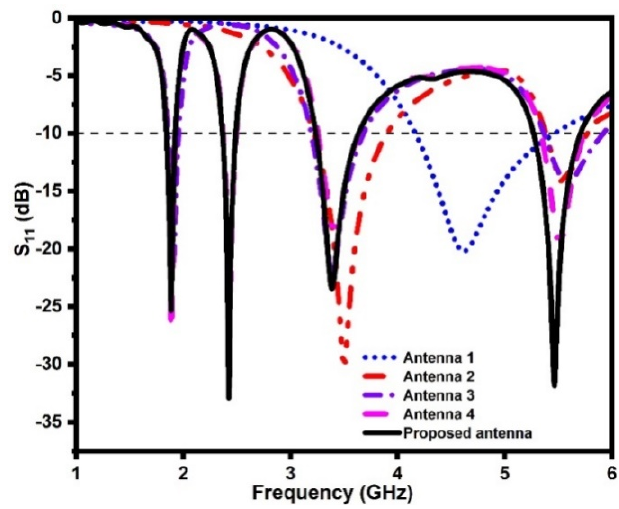
Figure 3. Reflection coefficients of the quad-band antenna design stages.